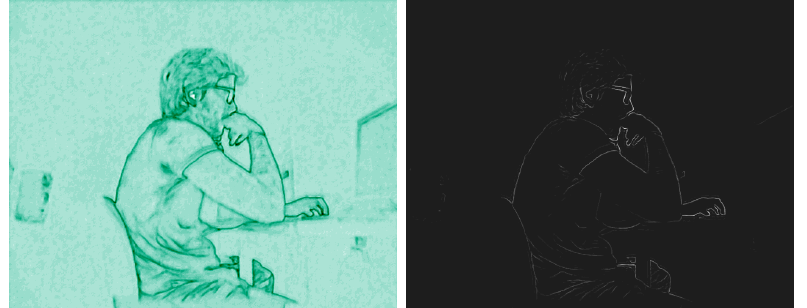
Figure 5. An example of a pair of (left) a confidence map and (right) a residual image (normalized and color mapped to deep green and gray for visualization).